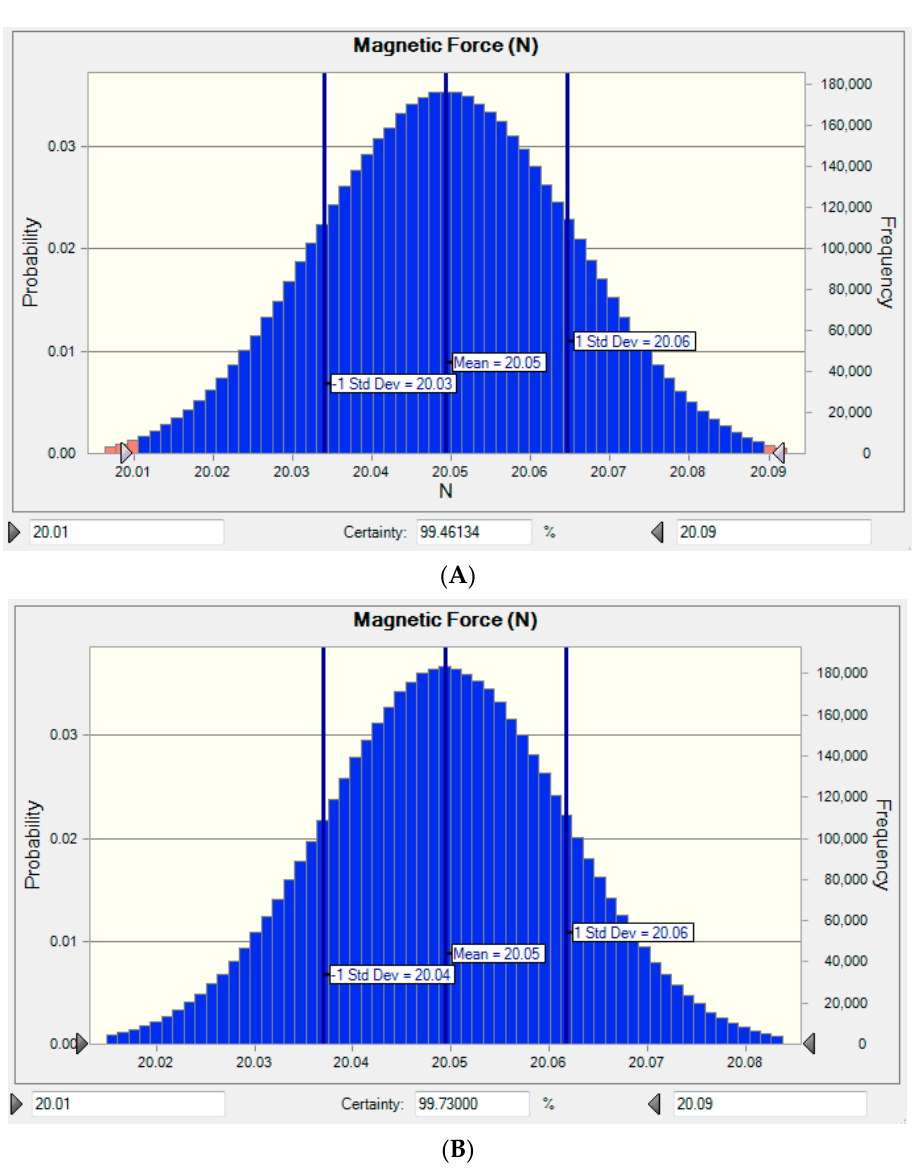
Figure 26. Comparison of reliability of electromagnetic force performance for design tolerance. ( A ) Electromagnetic force performance level within the range of design tolerance. ( B ) Electromagnetic force performance level in the range of design tolerance by the 3 sigma (3 σ ) level.